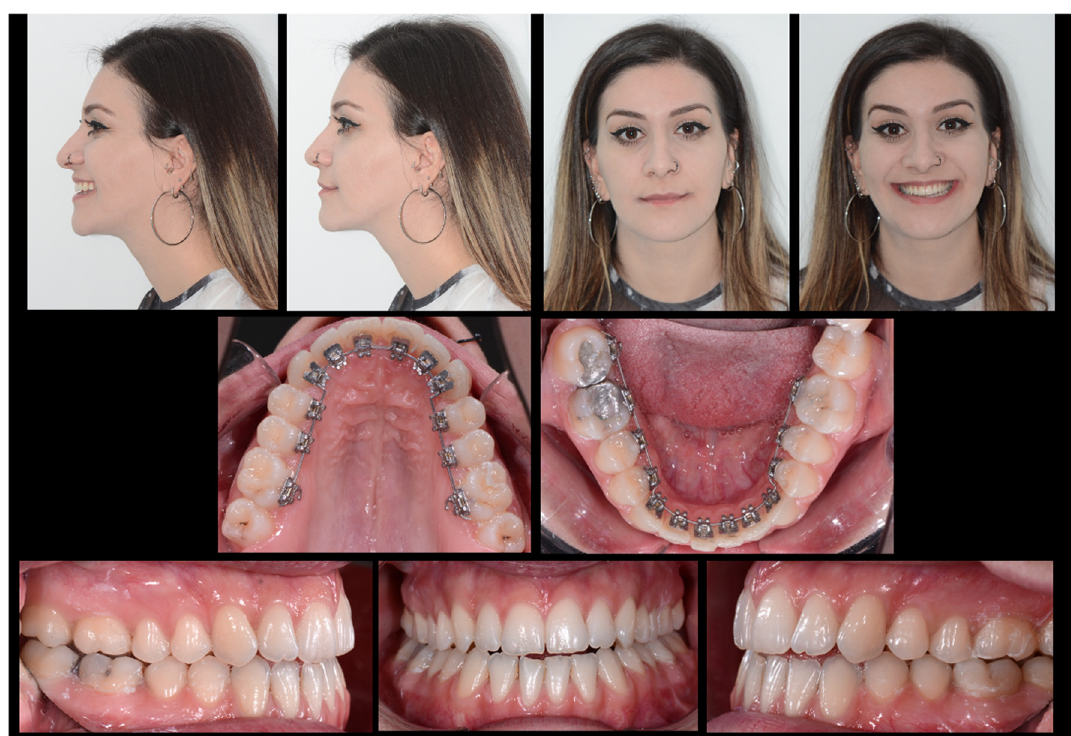
Figure 8. Extraoral and intraoral photographs 3 weeks after